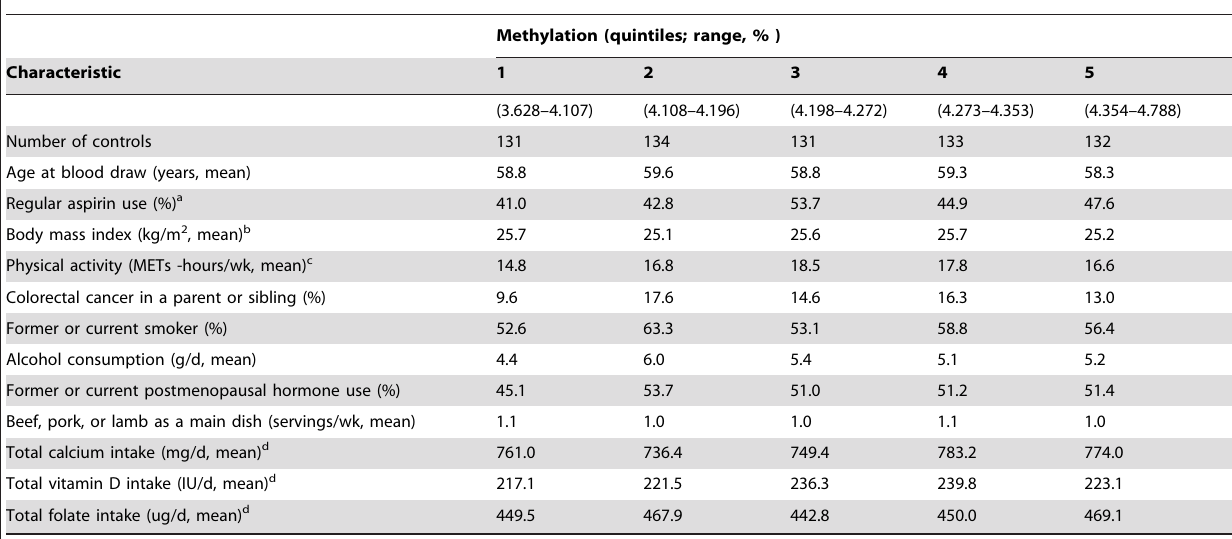
Table 2. Characteristics of colorectal cancer controls by levels of leukocyte genomic DNA methylation in a case-control study nested within the Nurses’ Health